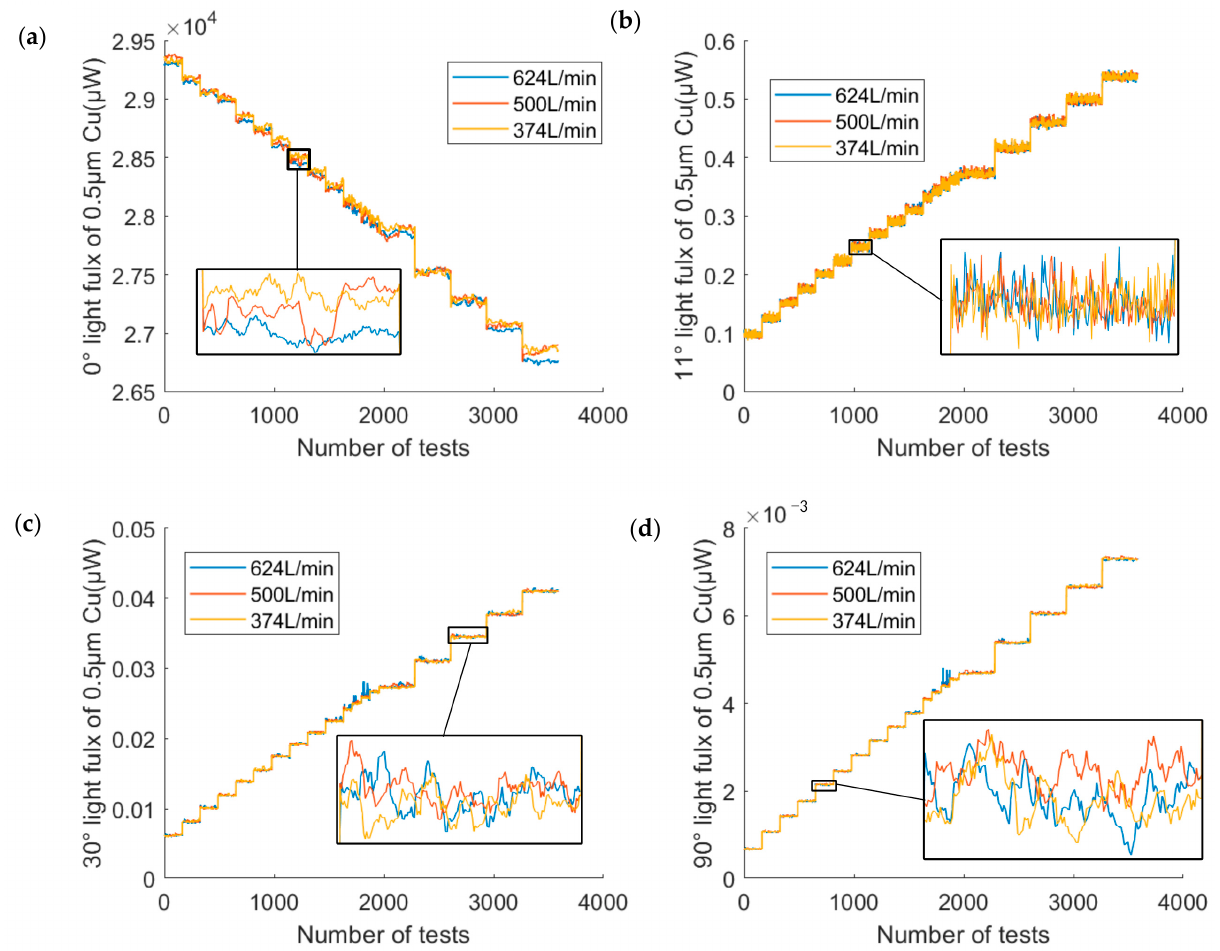
Figure 12. The data of 0.5 μ m copper particles at different flow rates at ( a ) 0° ( b ) 11° ( c ) 30°and ( d ) 90°.